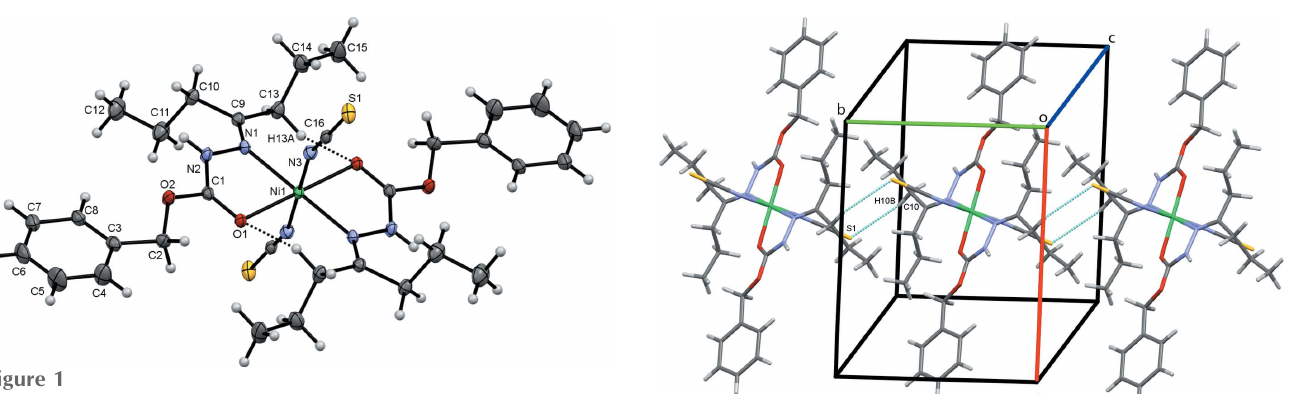
Figure 3 Chains of inversion dimers of 1 along b .